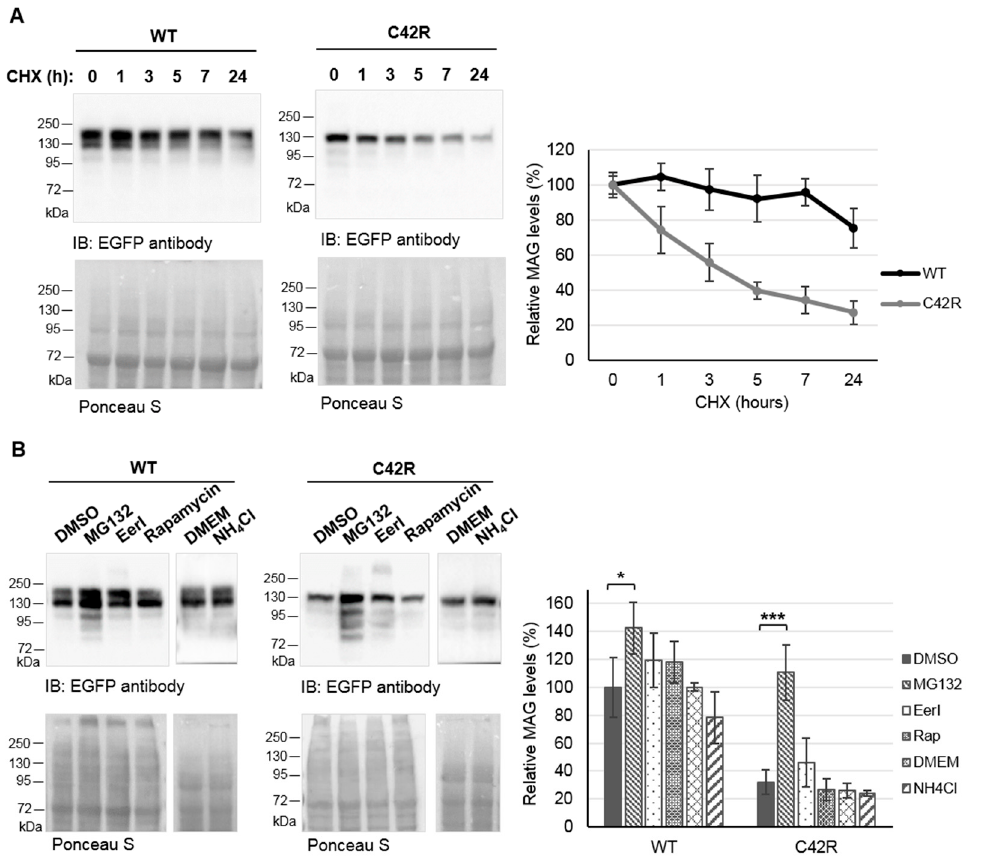
Figure 4. MAG-C42R impairs protein stability and is degraded by the proteasome. Cells expressing EGFP-tagged MAG clones were incubated with cycloheximide (CHX) for the indicated periods of time ( A ) or with different drugs for 18 h ( B ). Membranes were stained with Ponceau S for total protein quantification (whole blots are presented in Figure S4) and then cut and probed with anti-EGFP antibody. Quantification data are presented as the mean ± SEM ( A ) or mean ± SD ( B ) of three independent experiments; * p < 0.05, *** p < 0.001 (one-way ANOVA/Tukey).